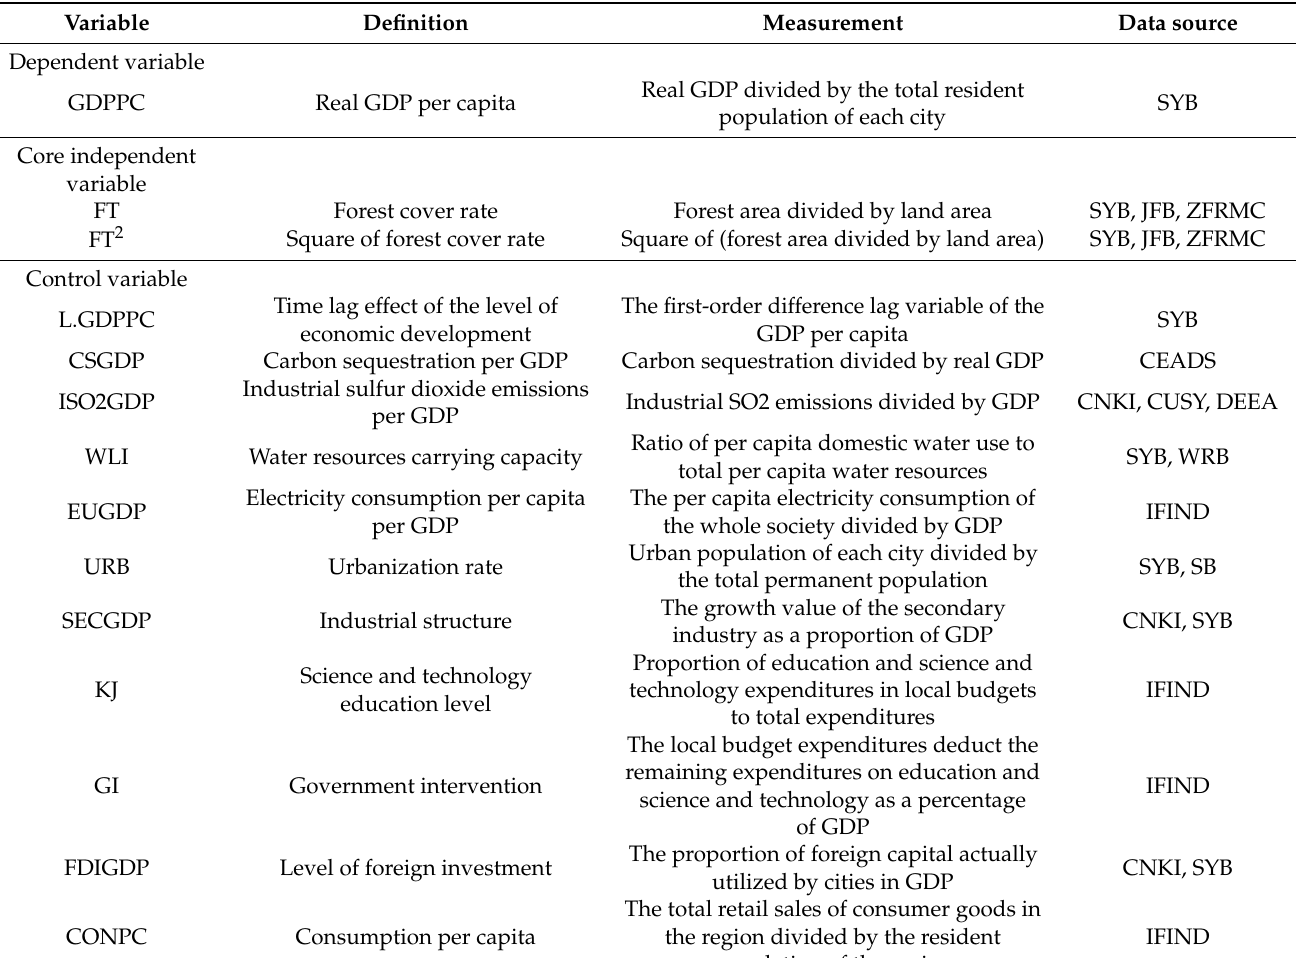
Table 2. Data source and variables.